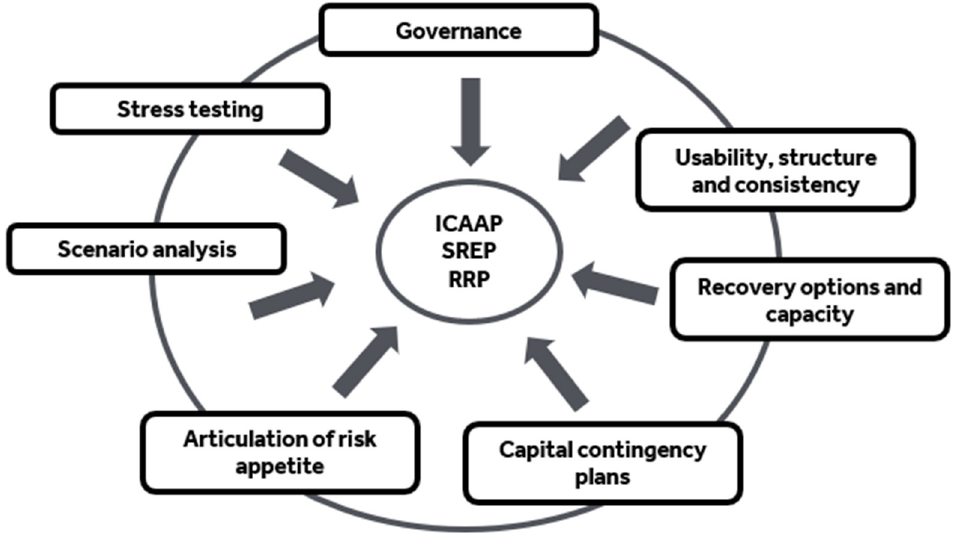
Figure 1. The PRA’s regulatory expectations and challenges.